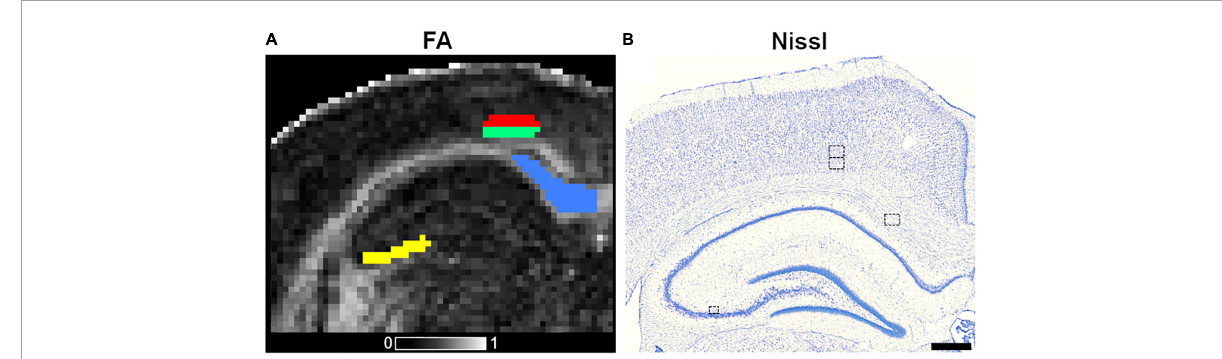
FIGURE1 Outlined ROIs in coronal fractional anisotropy (FA) map (A) and Nissl-stained section (B) from a control animal. The ROIs included in this study are corpus callosum (blue color), subfield CA3b of the hippocampus (yellow), layers V (red), and VI (green) of the parietal cortex, and the equivalent in the Nissl-stained section. The ROI area outlined on the histological photomicrographs in the left corpus callosum, layers V and VI of the parietal cortices was 180.81 × 141.31 µ m 2 , whereas the ROI area in CA3b was 104.42 µ m 2 × 89.89 µ m 2 . The gray scale reveals FA values between 0 (black) and 1 (white). Scale bar: 500 µ